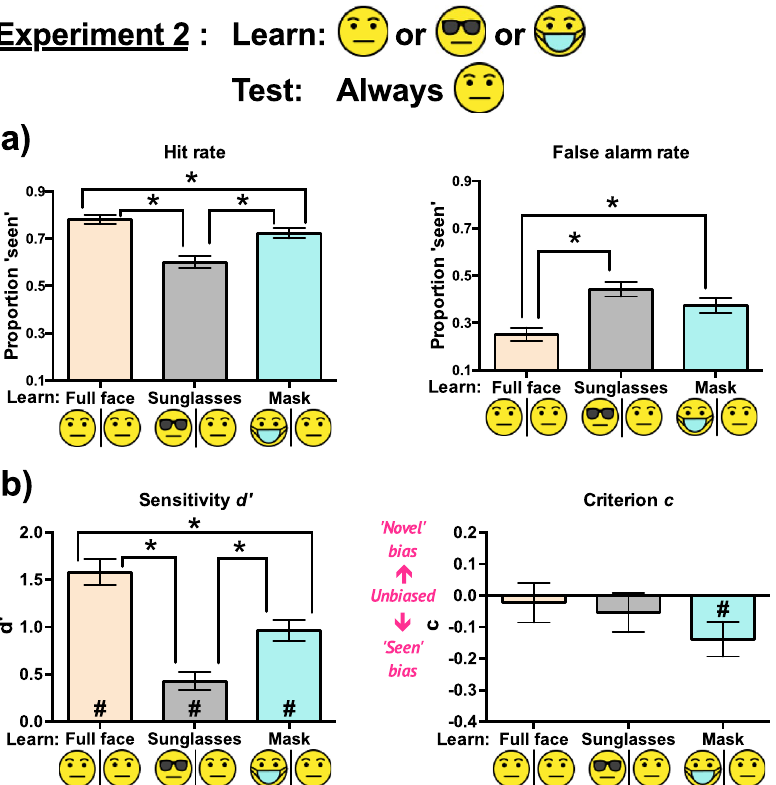
Figure 3. Experiment 2 results: ( a ) Hit rates and false alarm rates, and ( b ) sensitivities d’ and criteria c (indicating response biases) across the three conditions. All error bars represent ± 1 SEM. The asterisks (*) indicate significant pairwise differences between conditions. The hash signs (#) in ( b ) represent d’ or c significantly different from zero in the indicated conditions. The unmarked bars and comparisons were not statistically significant. The significance level was set at